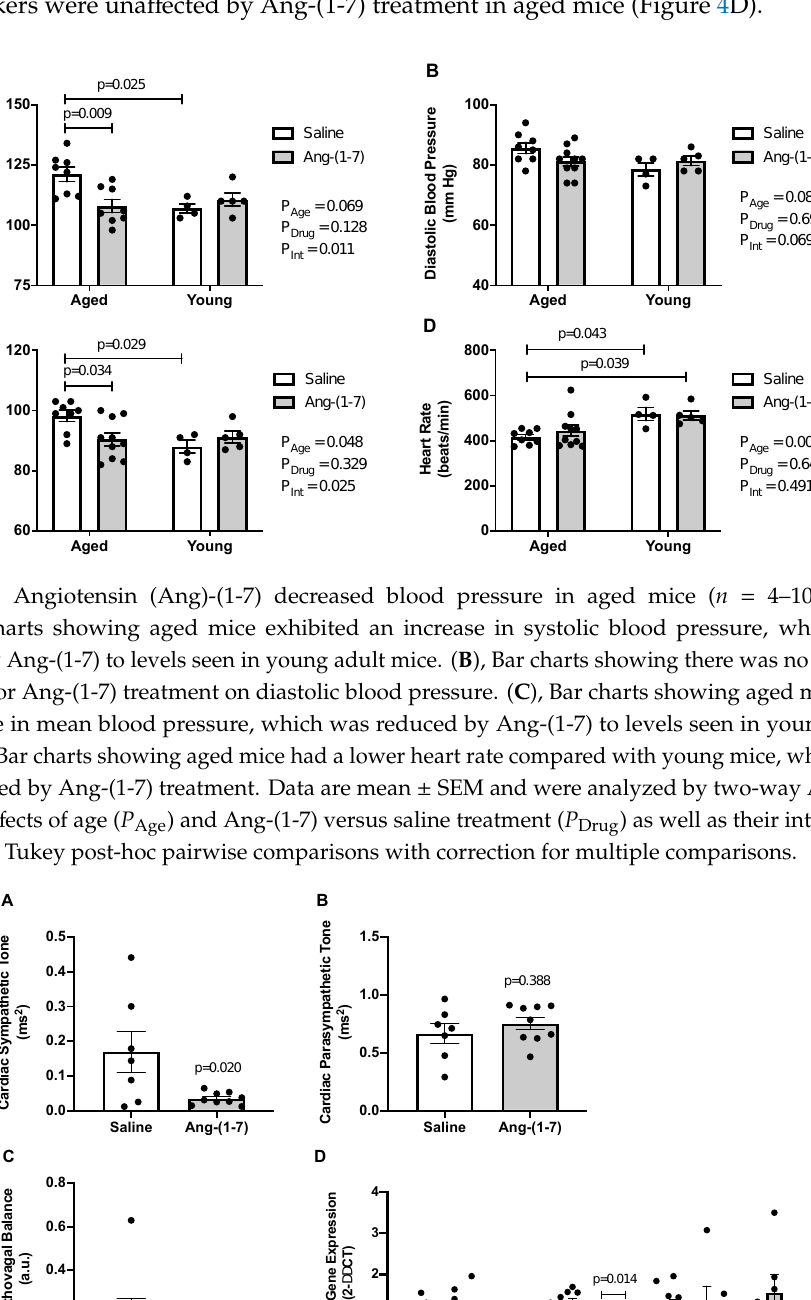
10 (IL10)) markers were una ff ected by Ang-(1-7) treatment in aged mice (Figure 4D). Int. J. Mol. Sci. 2020 , 21 , x FOR PEER REVIEW